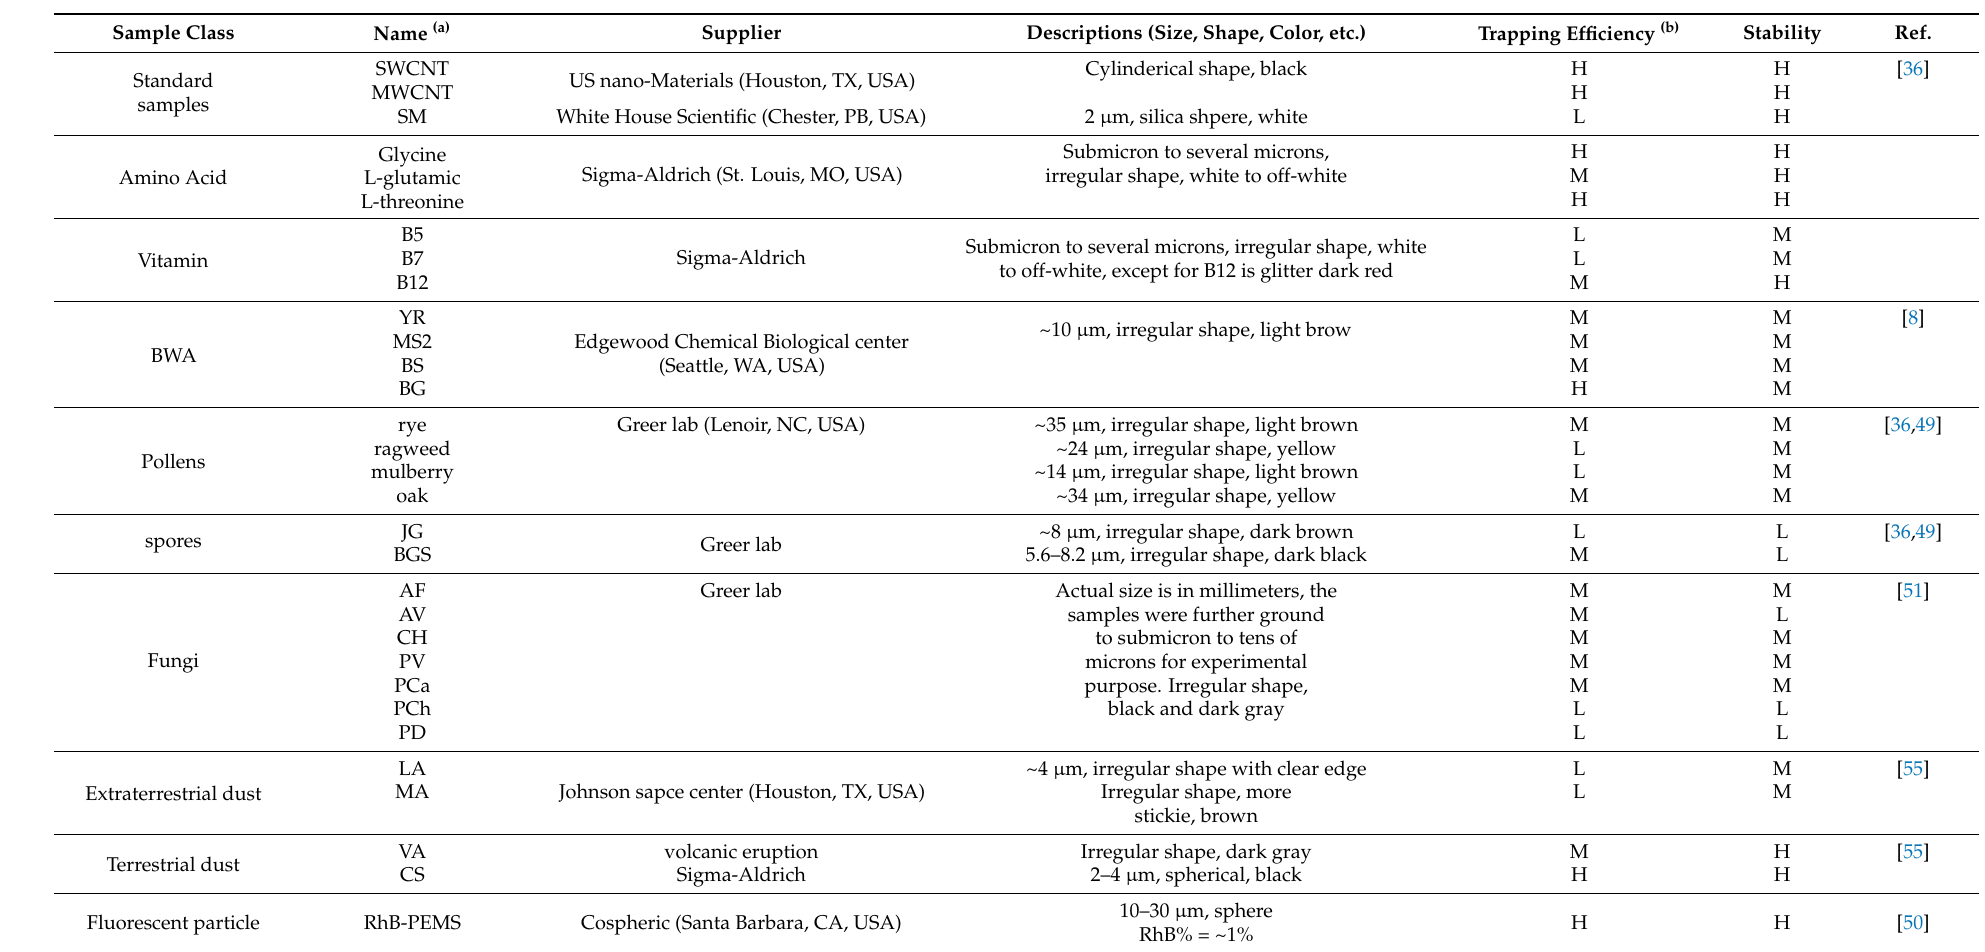
Table 1. A list of the samples along with their suppliers and brief